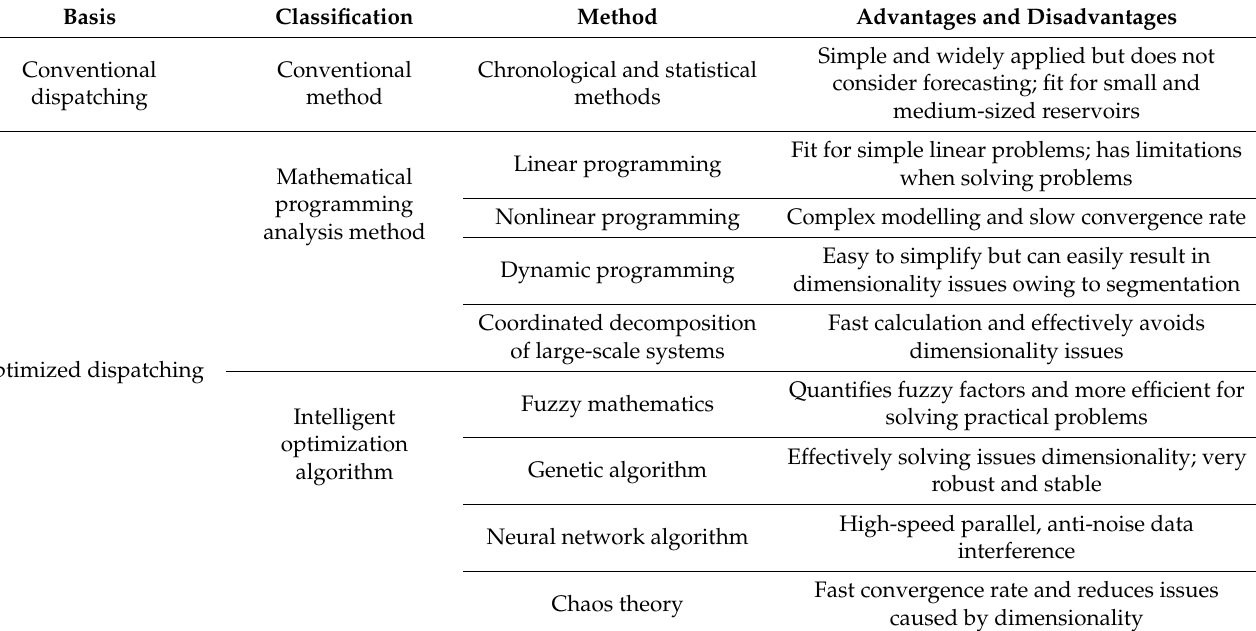
Table 1. Dispatching algorithms used by water Resource dispatching systems (WRDSs) in China.